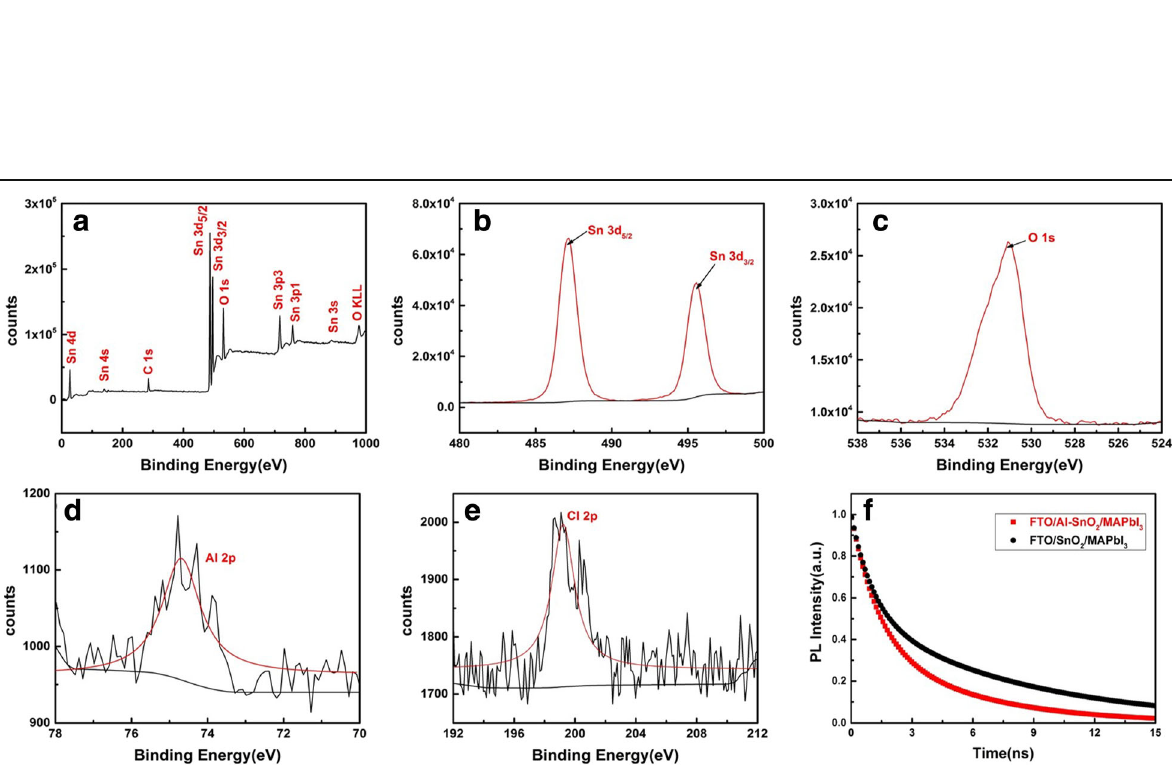
Fig. 3 XPS spectra of a survey, b Sn 3d, c O 1 s, d Al 2p, and e Cl 2p peaks for Al-SnO 2 film deposited on the FTO substrate. f Normalized time-resolved PL decay curves of MAPbI 3 films deposited on SnO 2 ( black line ) and Al-SnO 2 ( red line ) coated